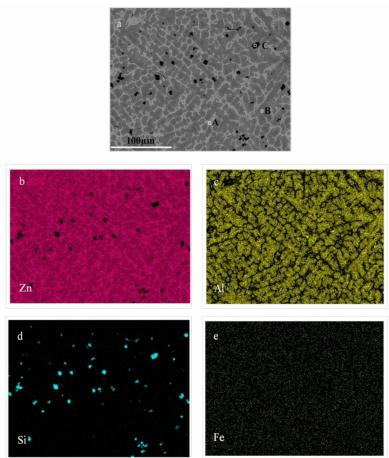
Figure 9. Elemental distributions of Zn–Al alloy. ( a ) SEM of Zn–Al alloy; ( b ) Distribution of zinc; ( c ) Distribution of aluminum ; ( d ) Distribution of silicon ; ( e ) Distribution of